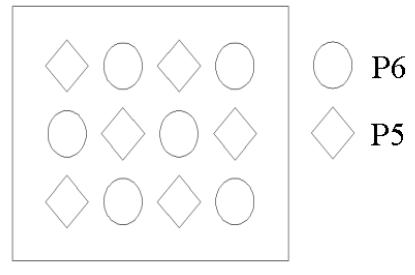
Figure 11. Layout scheme of pile type.